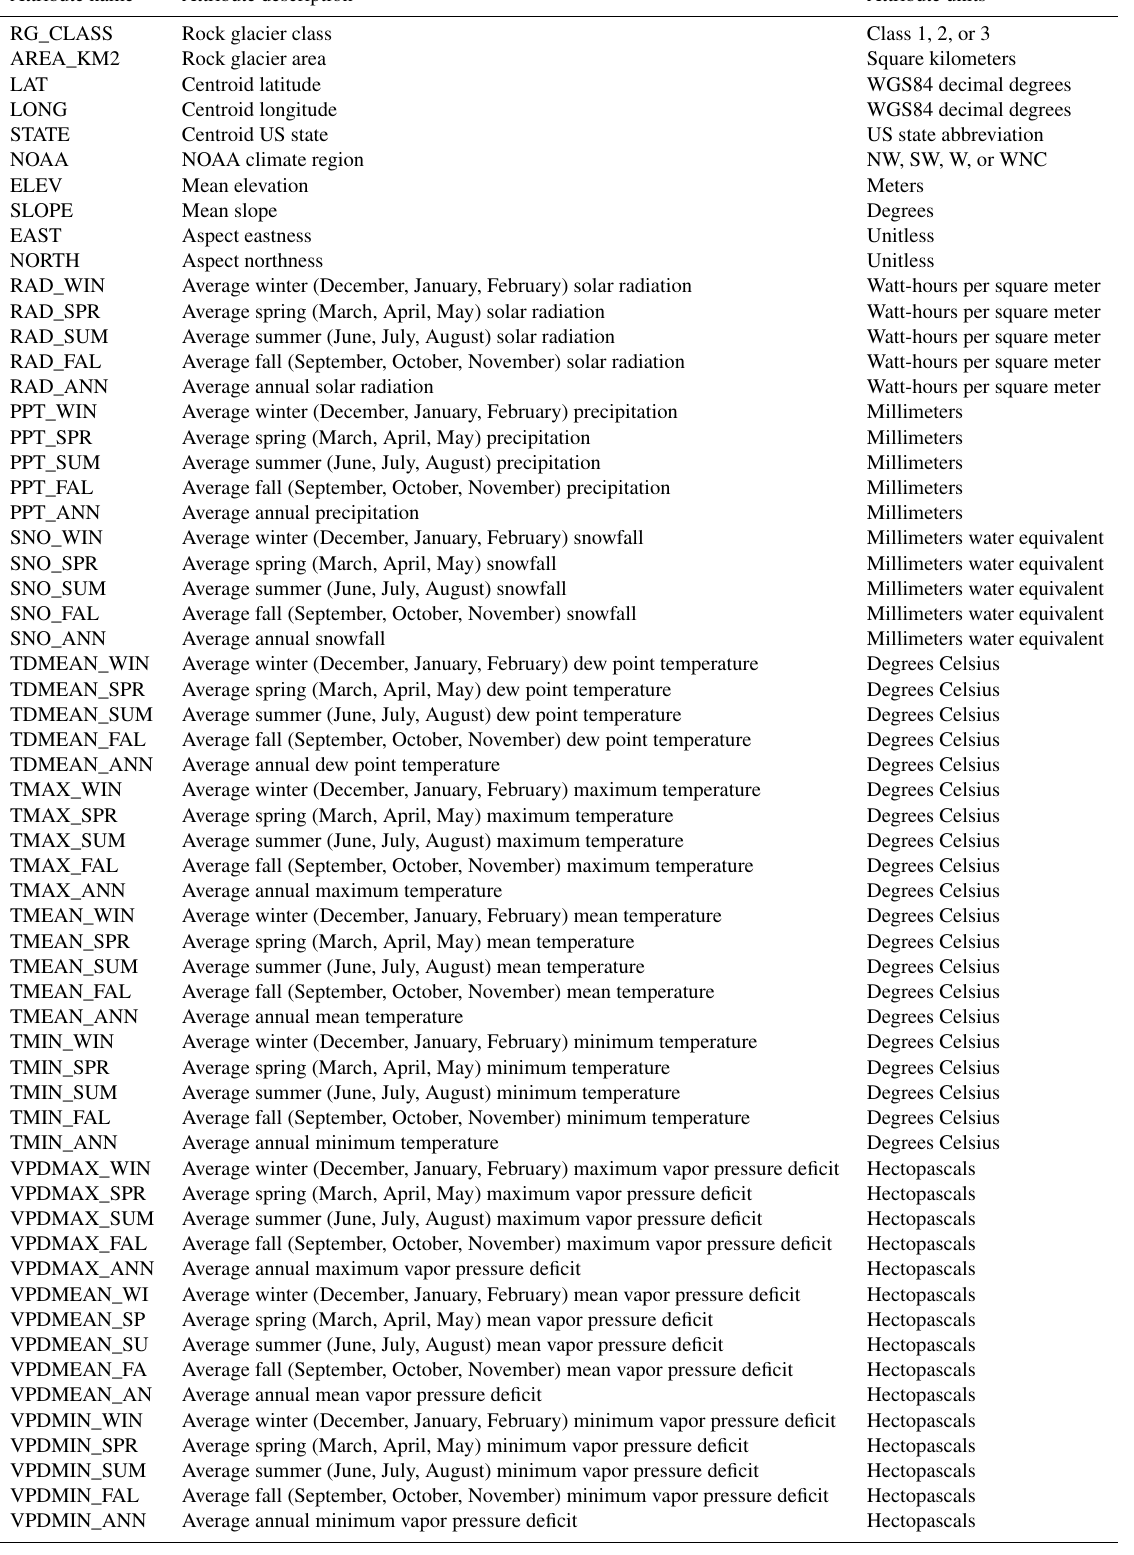
Table 5. Portland State University Active Rock Glacier Inventory shapefile attribute data